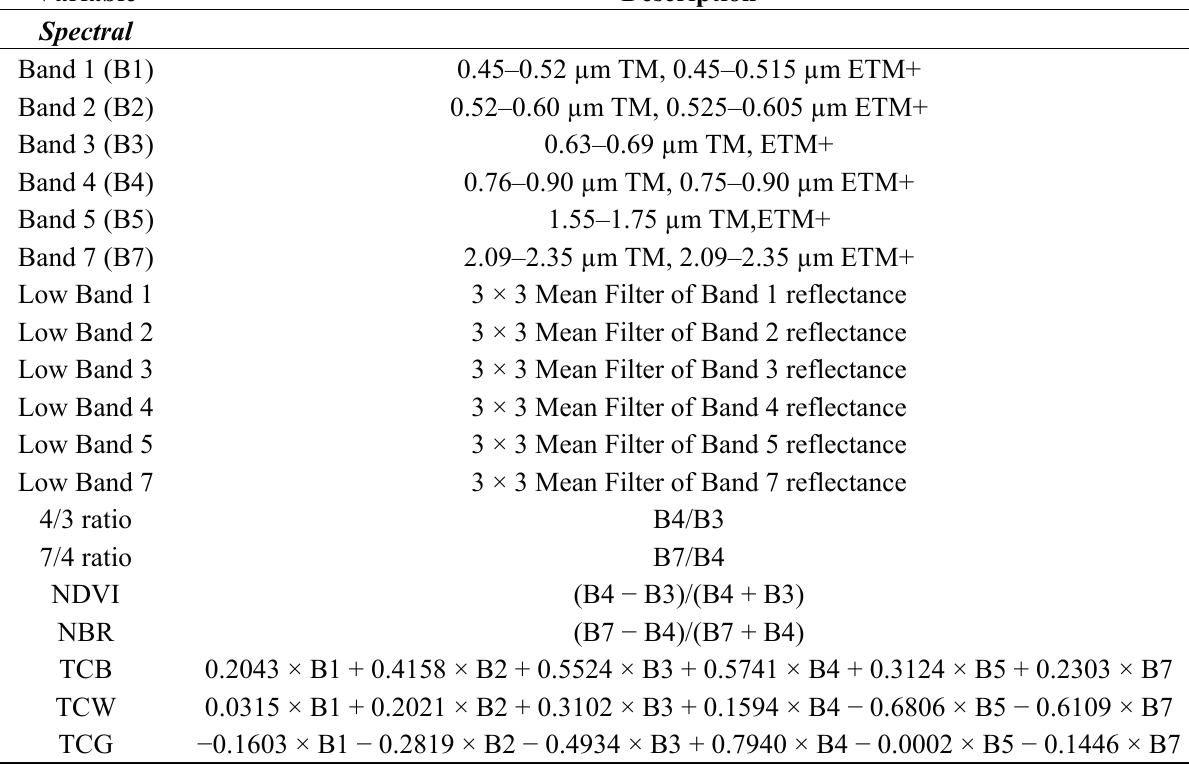
Table 2. Spectral and ancillary input variables. Band numbers represent bands from the Landsat TM and ETM+ sensors. Indices and transforms include the normalized differenced vegetation index (NDVI), normalized burn ratio (NBR), tasseled cap